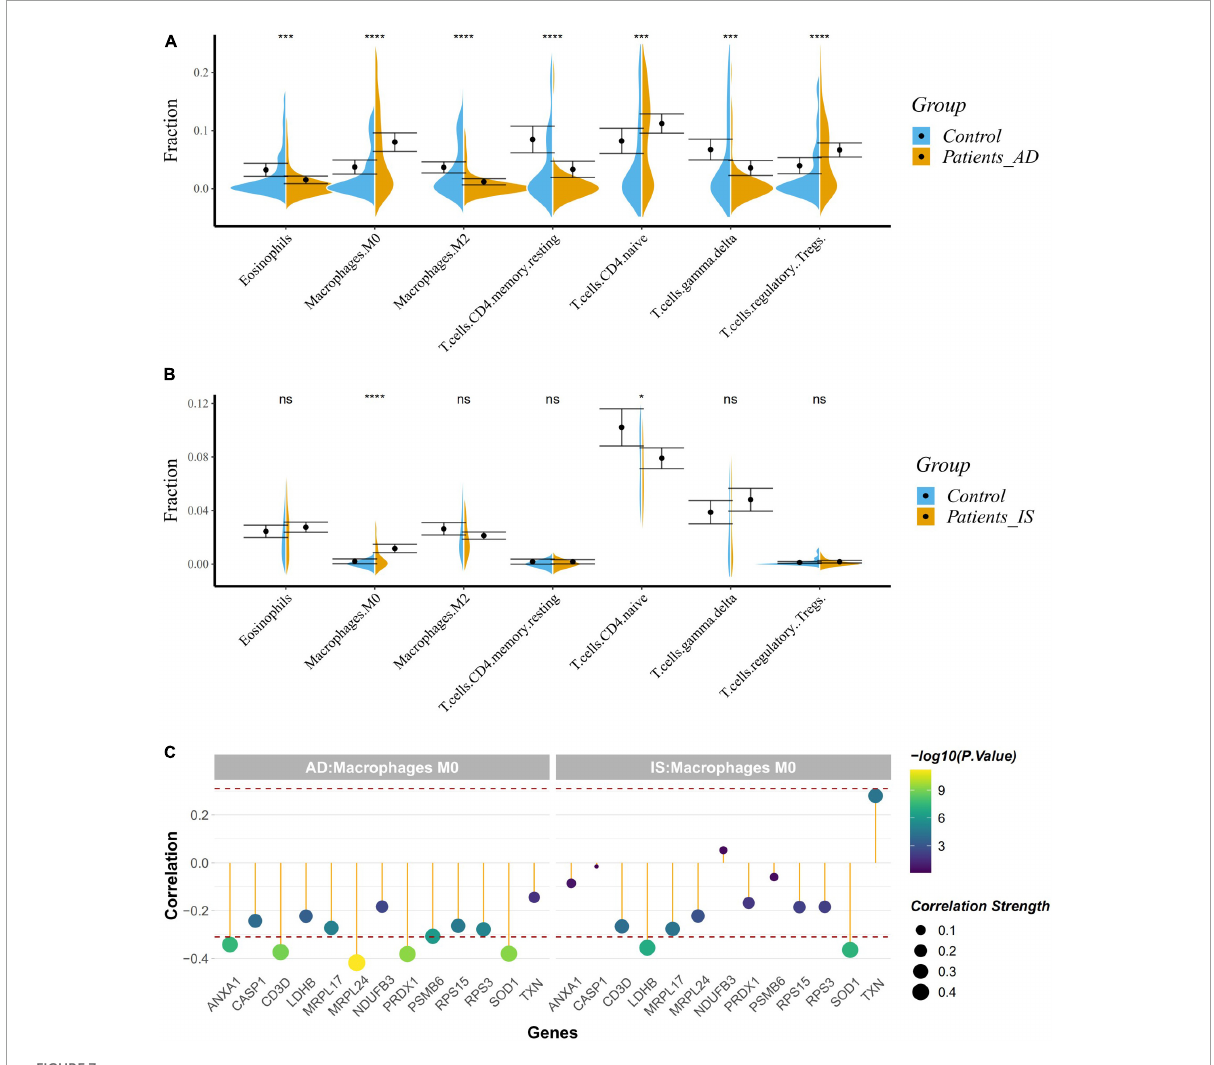
FIGURE7 (A,B) Violin diagram showing the proportion of immune cells obtained using the CIBERSORT. * P < 0.05; *** P < 0.001; **** P < 0.0001. (C) Correlation between hub genes and drug target genes, and M0 macrophages. The red dashed lines represent +0.3 and